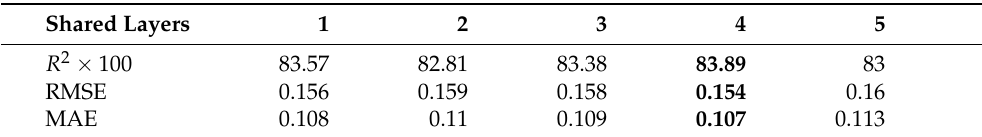
Table 3. Chl-a estimation levels of the proposed multitask model across 10-fold cross-validation with different number of shared layers among the two task branches, with the best results in bold, where R 2 , MAE, and RMSE denote the coefficient of determination, mean absolute error, and root mean square error, respectively (patch size = 3 × 3).